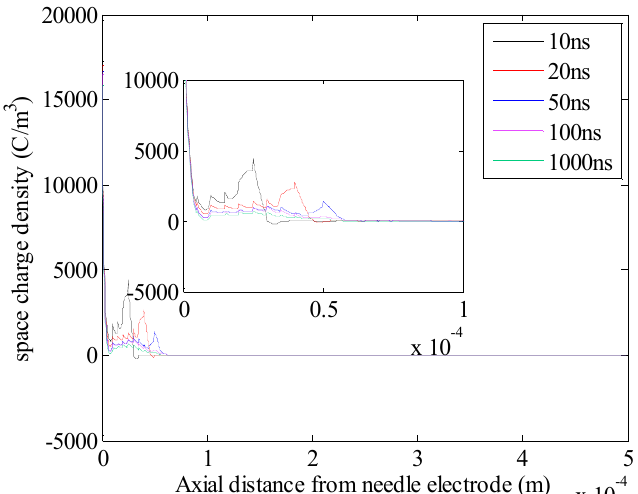
Figure 17. Space charge density distribution along the needle-sphere axis as a response to 1.2 PDIV with 5 mm needle-sphere electrode